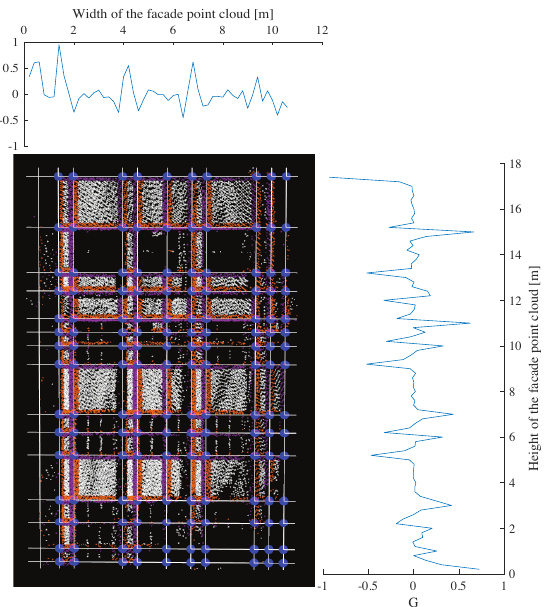
Figure 5. Window detection by the sliding window method from the mobile LiDAR data.The height and width of the fac¸ade point cloud are 17 . 66 m and 10 . 97 m respectively. The plot of vertical gradient values is on the top of the figure and that of the horizontal gradients is placed on the right-hand